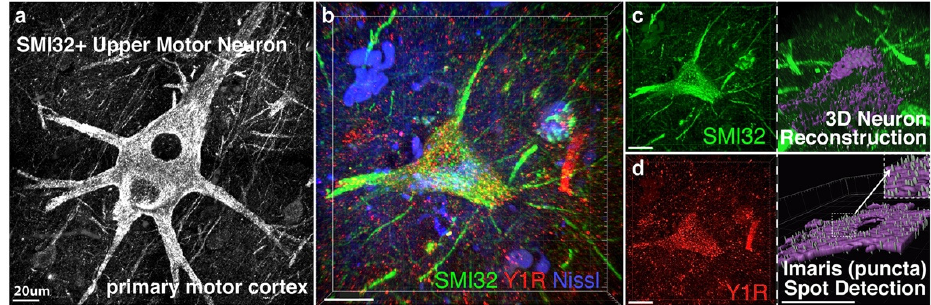
Figure 1. For NPY-Y1 receptor quantification upper motor neurons were visualized with the neurofilament protein SMI32 in human motor cortex ( a ), or with the fluorescent protein YFP-H in YFP-H rodent motor cortex, and reconstructed from z-stack images using Imaris software. Z-stack image showing an SMI32-positive upper motor neuron in post-mortem human tissue (green) labelled with the NPY-Y1 receptor (red) and the neuronal marker Nissl (blue) ( b ). NPY-Y1 receptor puncta/µm 3 was determined on three-dimensional (3D) rendered neurons (purple) ( c ) using spot detection algorithms ( d ). Imaris object detection feature allowed for isolation of cell soma ( c ) or apical process compartments for puncta analysis per volume of object reconstructed. Insert in ( d ) shows synaptic puncta detected using Imaris. Scale bars = 20 µm.